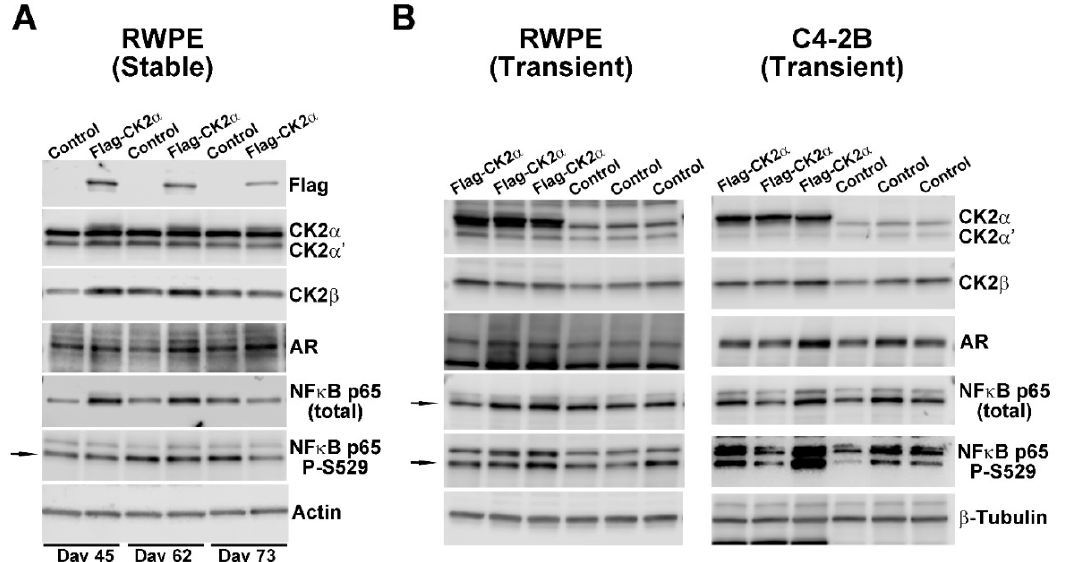
Figure 1. Effects of increased CK2α expression on AR and NFκB p65 protein levels. ( A ) Immunoblot analysis of RWPE-1 cells stably expressing Flag-CK2α after 45, 62 and 73 days in culture. Control lanes represent either parental RWPE-1 cells or RWPE-1 cells stably expressing empty vector collected simultaneously with Flag-CK2α cells. Proteins detected are indicated on the right side of the blots. Actin signal was used as the loading control. ( B ) Immunoblot analysis of RWPE-1 and C4-2B cell lysates 24 h after transient transfection with Flag-CK2α expression construct. Control lanes represent empty vector transfected cells. β-Tubulin signal was used as the loading control. Arrows indicate correct band.